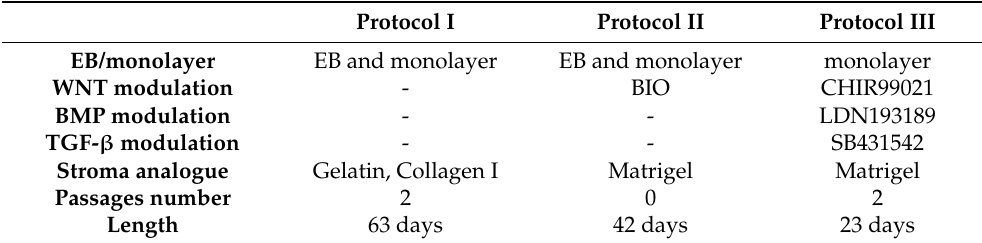
Table 1. Comparison of myogenic